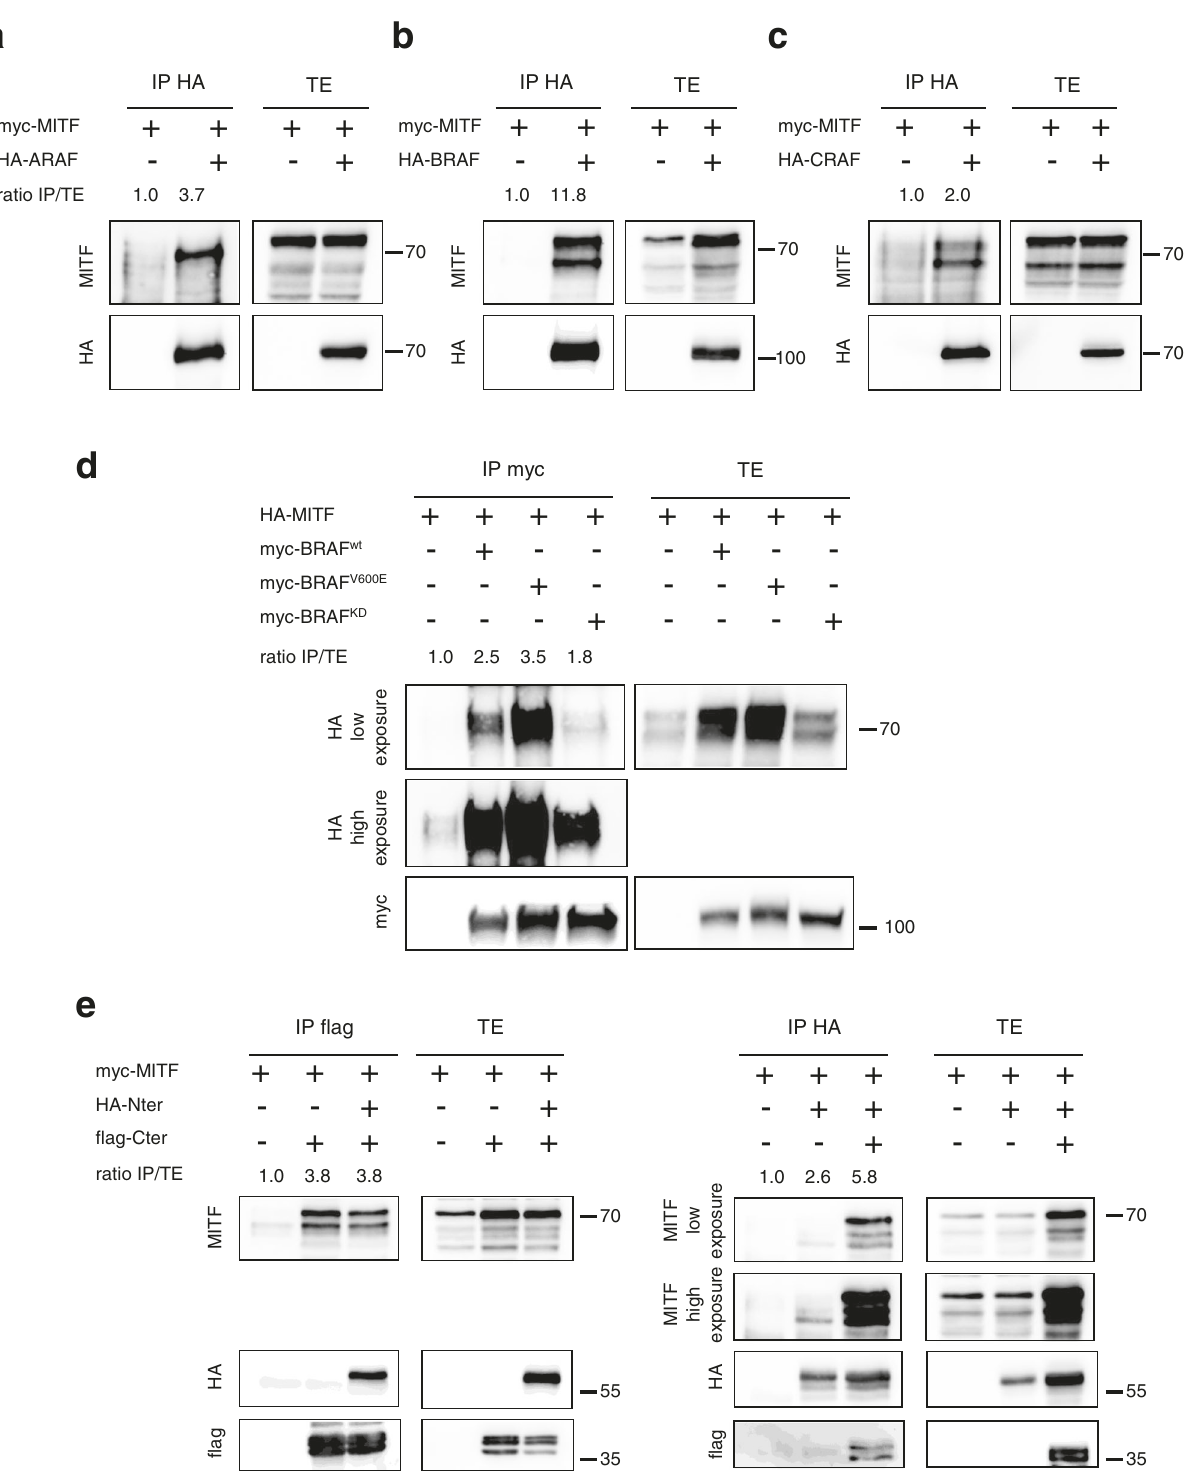
localization was analysed by immuno fl uorescence (Fig. 5). When expressed alone, MITF was mainly nuclear while RAF proteins displayed a clear cytoplasmic localization. However, when co- expressed, a relocalization of MITF from nucleus to cytoplasm was observed, indicating that complexes between MITF and ARAF, BRAF or CRAF, are cytoplasmic in agreement with